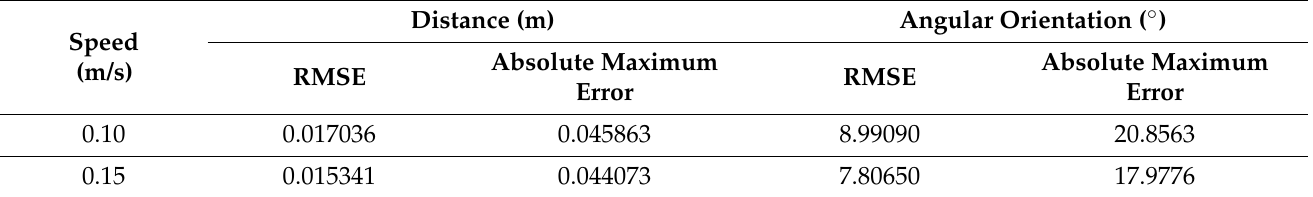
Table 2. Path-tracking errors obtained in the case of performing an eight-shaped target trajectory (Figure 7b).